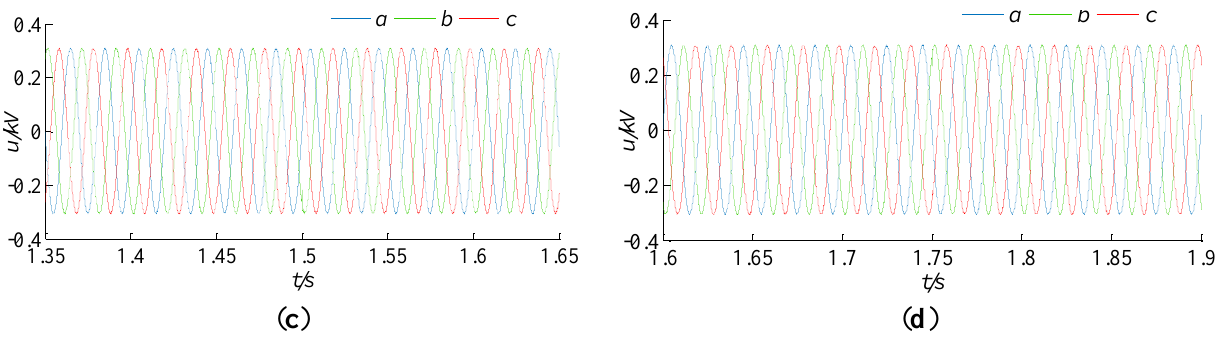
Figure 10. ( a ) Output voltage waveforms of DG PV between 0.35 s and 0.65 s; ( b ) Output voltage waveforms of DG PV between 0.85 s and 1.15 s; ( c ) Output voltage waveforms of DG PV between 1.35 s and 1.65 s; ( d ) Output voltage waveforms of DG PV between 1.6 s and